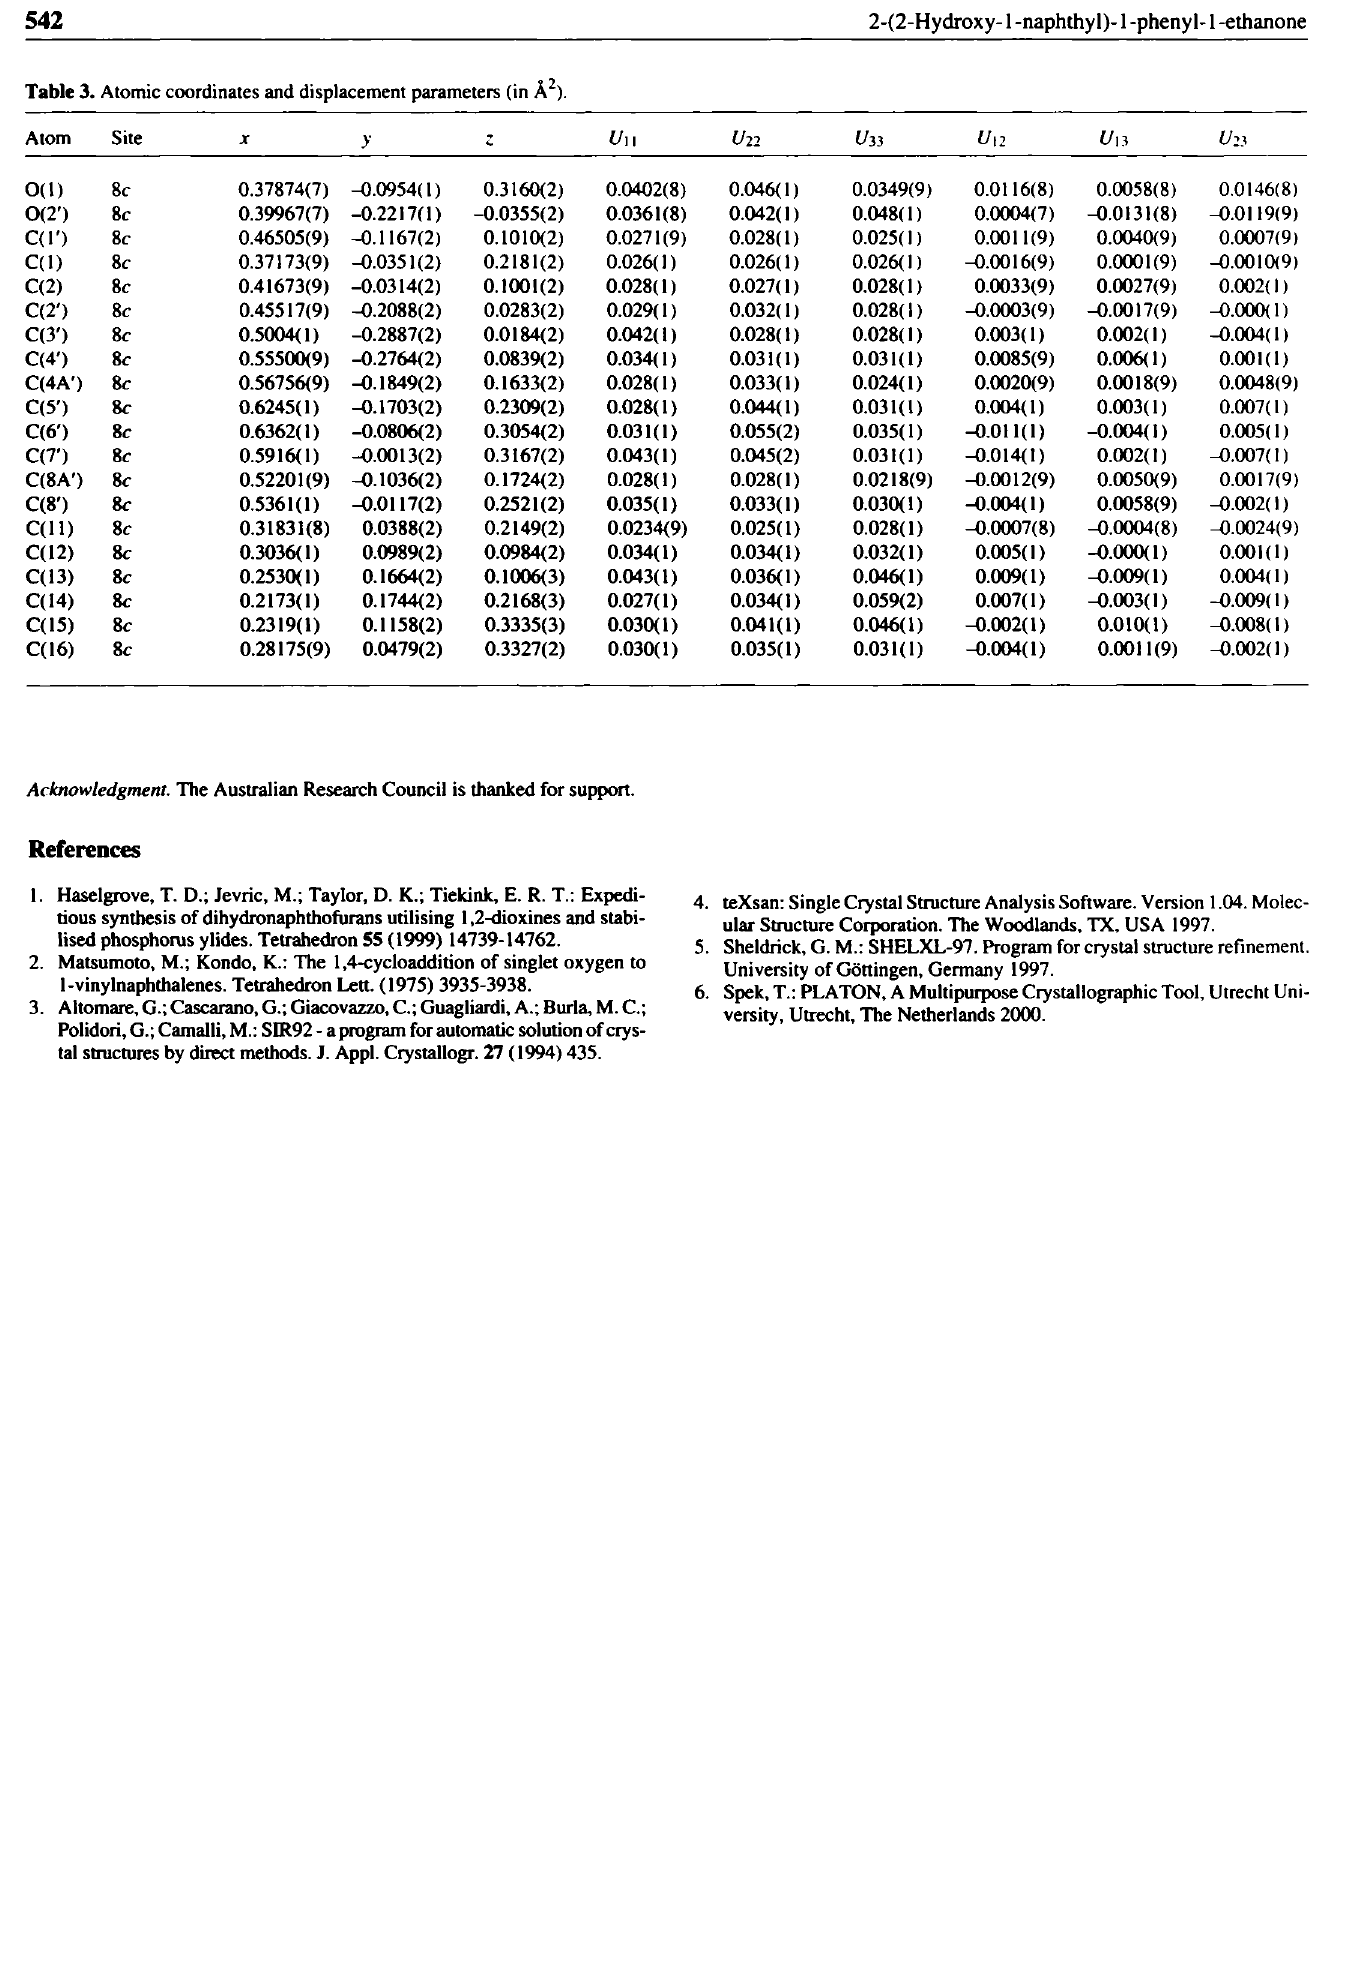
Table 3. Atomic coordinates and displacement parameters (in Ä 2